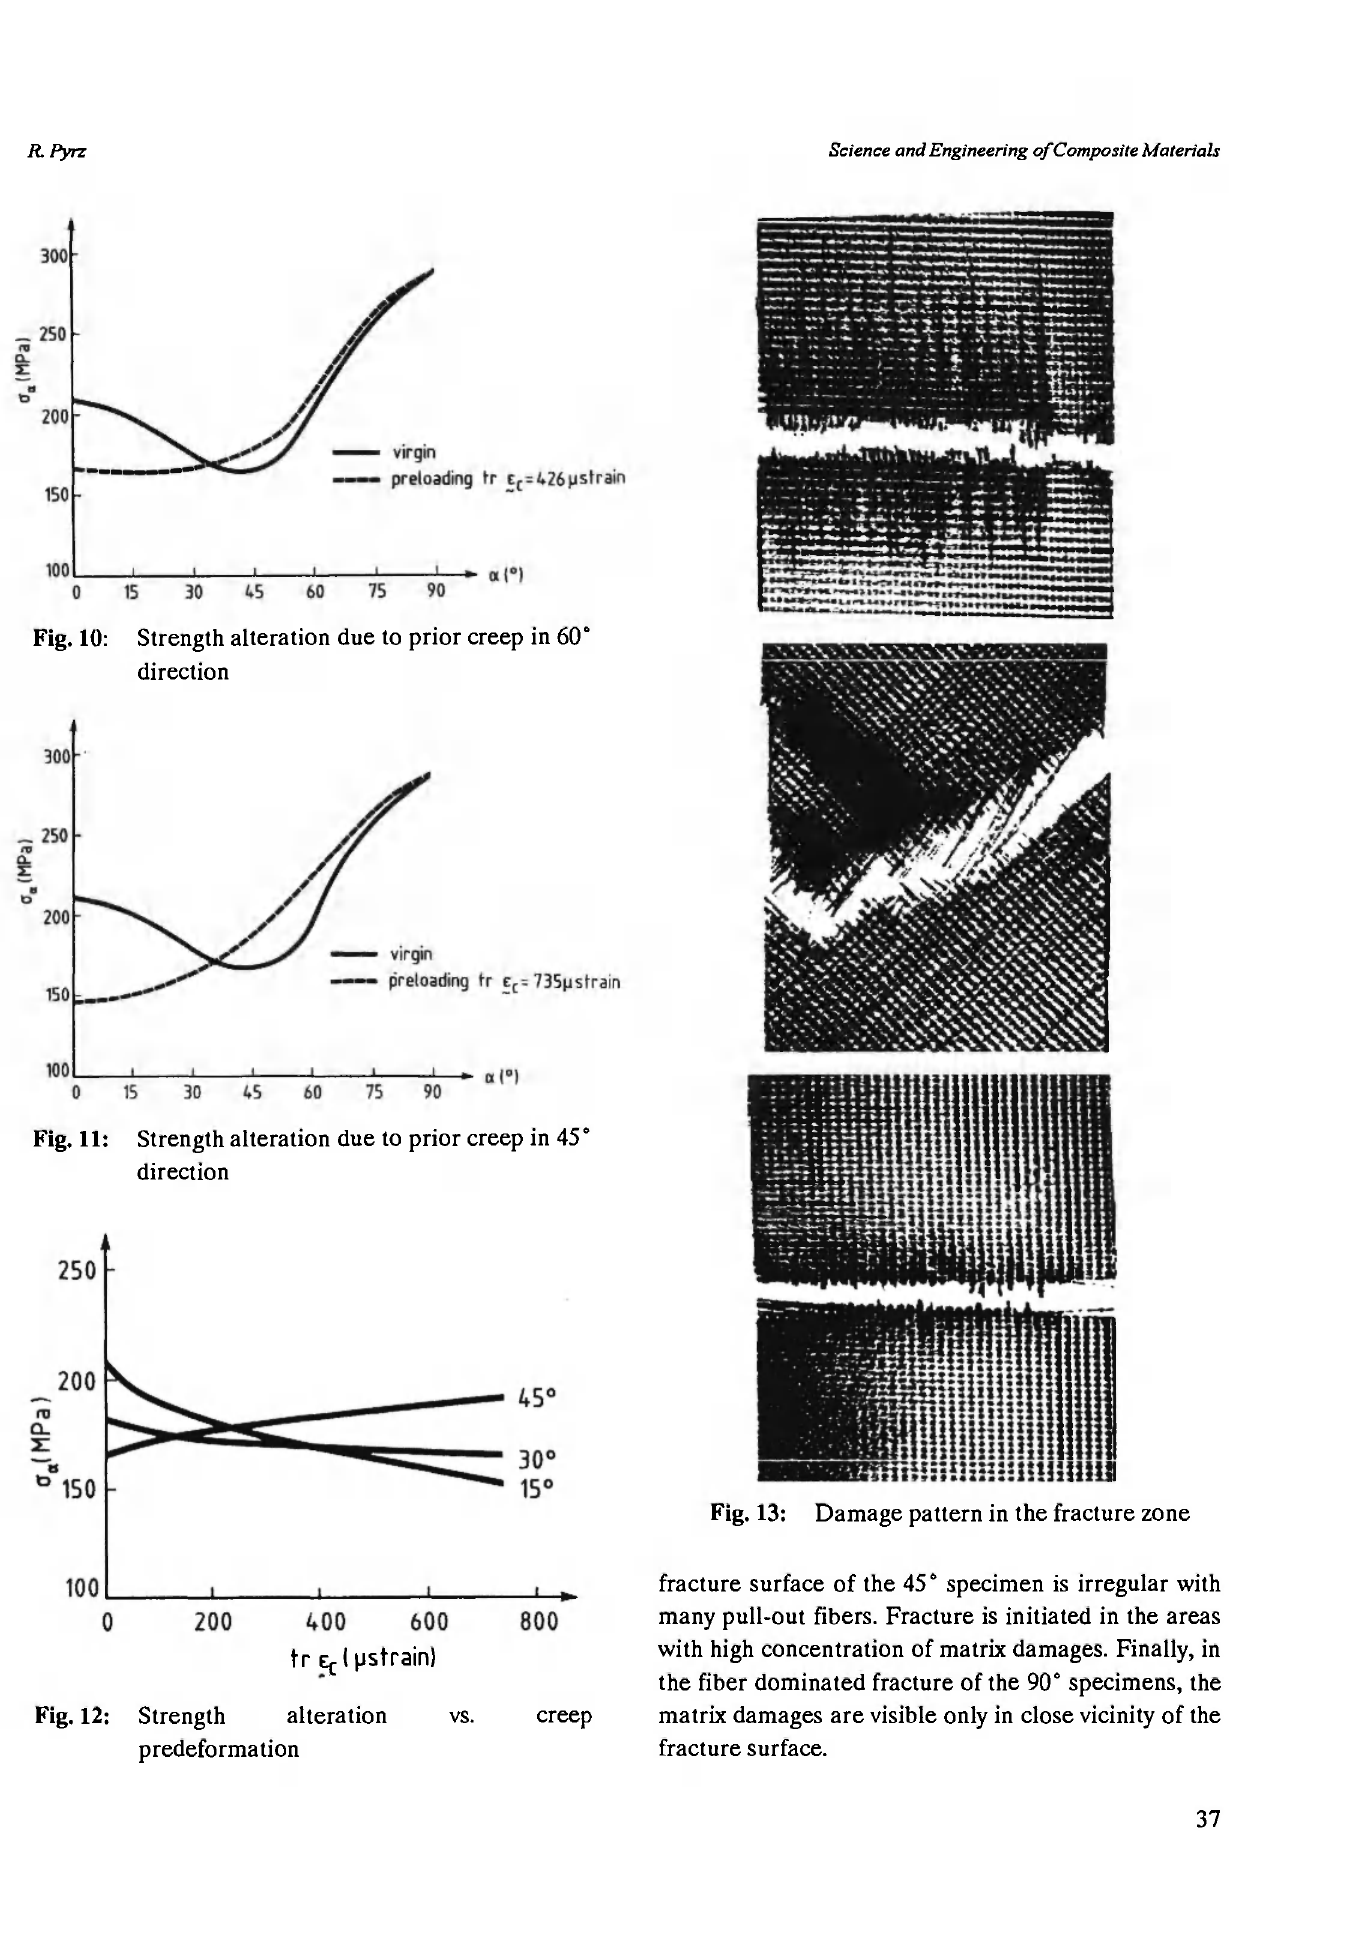
Damage pattern in the fracture zone fracture surface of the 45° specimen is irregular with many pull-out fibers. Fracture is initiated in the areas with high concentration of matrix damages. Finally, in tr Eflpstrain) the fiber dominated fracture of the 90° specimens, the matrix damages are visible only in close vicinity of the Fig. 12: Strength alteration vs. creep fracture predeformation